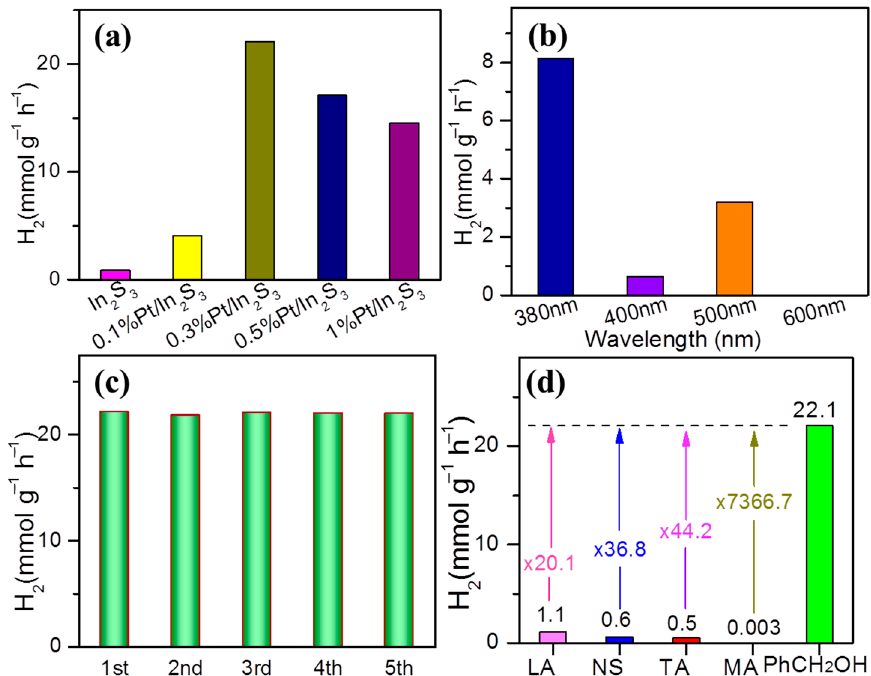
Figure 6. ( a ) The PHP activity of In 2 S 3 and Pt/In 2 S 3 with different Pt weight ratios for photocatalytic selective oxidation of phenylcarbinol and H 2 production under simulated sunlight irradiation. ( b ) The PHP activity of 0.3% Pt/In 2 S 3 under monochromatic light irradiation with different wavelengths. ( c ) The PHP activity of 0.3% Pt/In 2 S 3 under simulated sunlight irradiation for 5 recycles. ( d ) Comparison of 0.3% Pt/In 2 S 3 PHP activity in different reaction systems (LA, NS, TA,